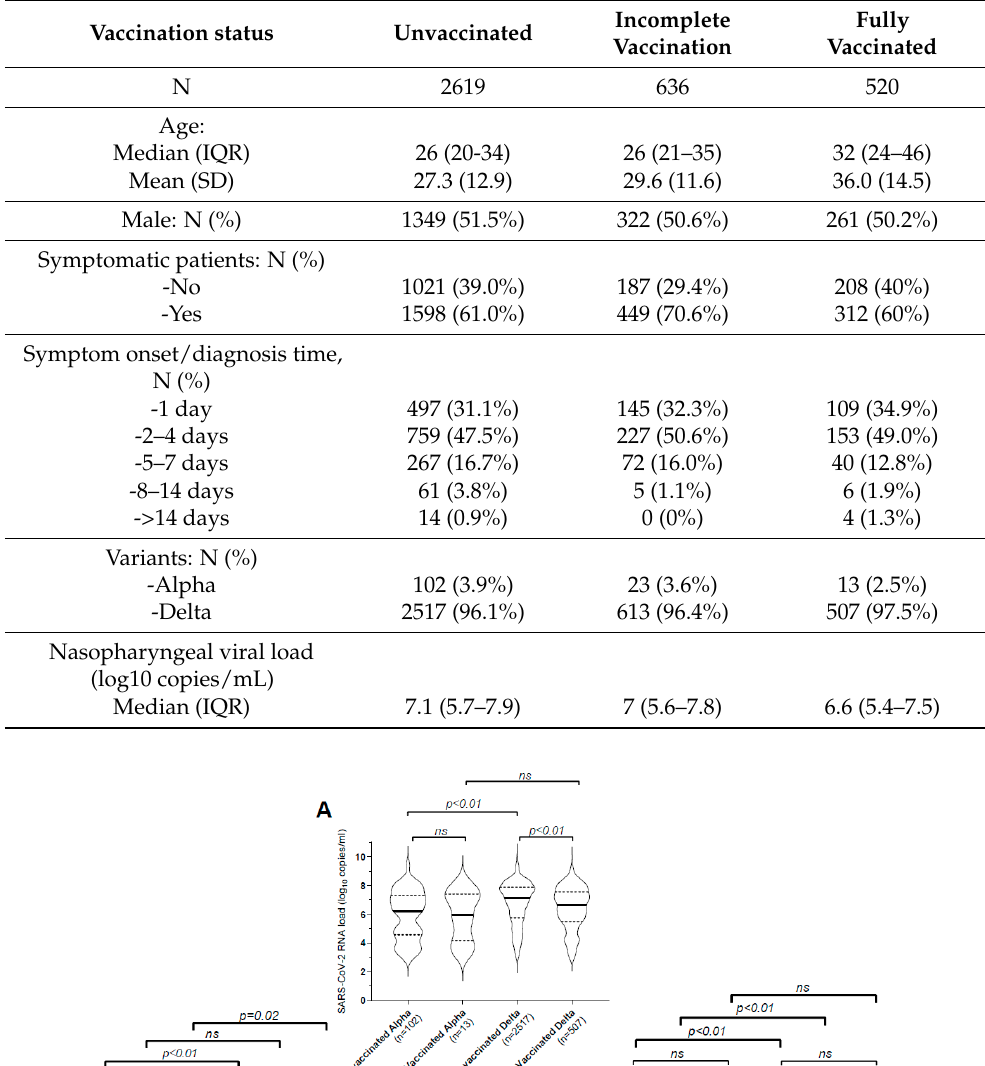
Table 2. Population characteristics according to their vaccination status.